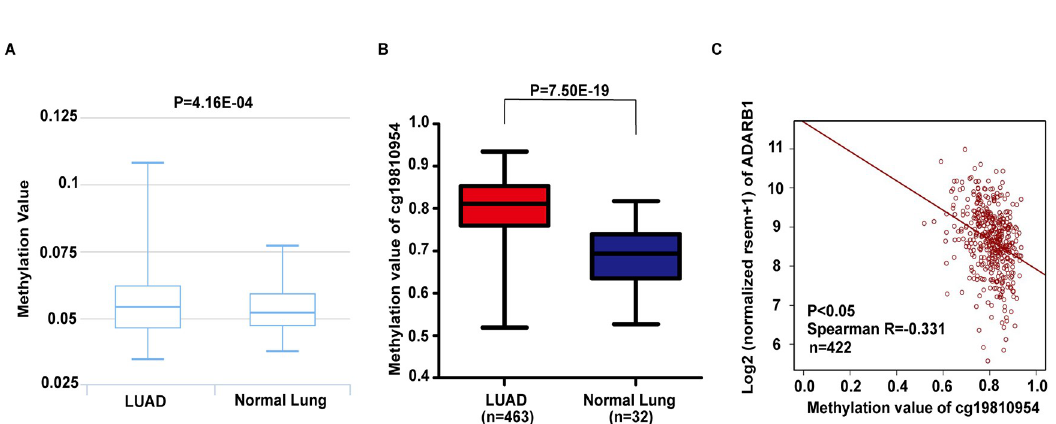
Fig 5. Methylation values of ADARB1 in LUAD patients. (A) Global ADARB1 methylation in LUAD samples compared with that in normal samples was analyzed by the DiseaseMeth version 2.0 database. (B) The data acquired from the Wanderer database indicated the highest methylation value of cg19810954 in ADARB1. (C) Negative correlations between cg19810954 methylation and the ADARB1 expression level.